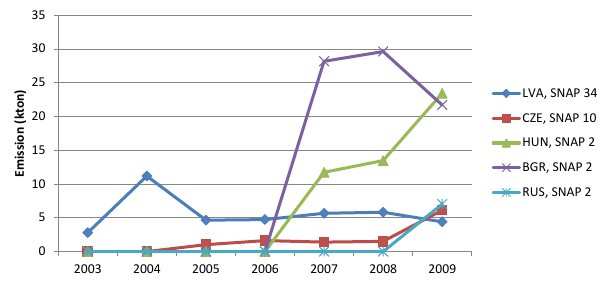
Figure 1. Observed trends in PM 10 reported emissions for selected countries and SNAP level 1 source categories (source: CEIP,